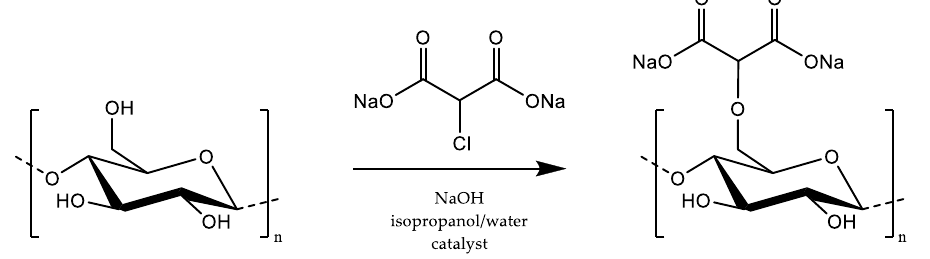
Figure 1. Schematic representation of the synthesis of dicarboxymethyl cellulose sodium salt.